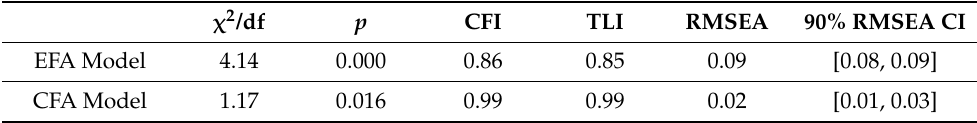
Goodness-of-fit indices for the baseline EFA model and the CFA model for the StWTA-HS